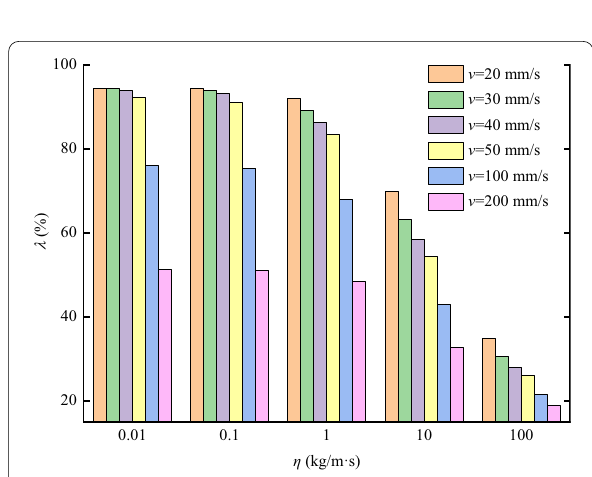
Figure 13 The influence curve of the sediments dynamic viscosity on the coring